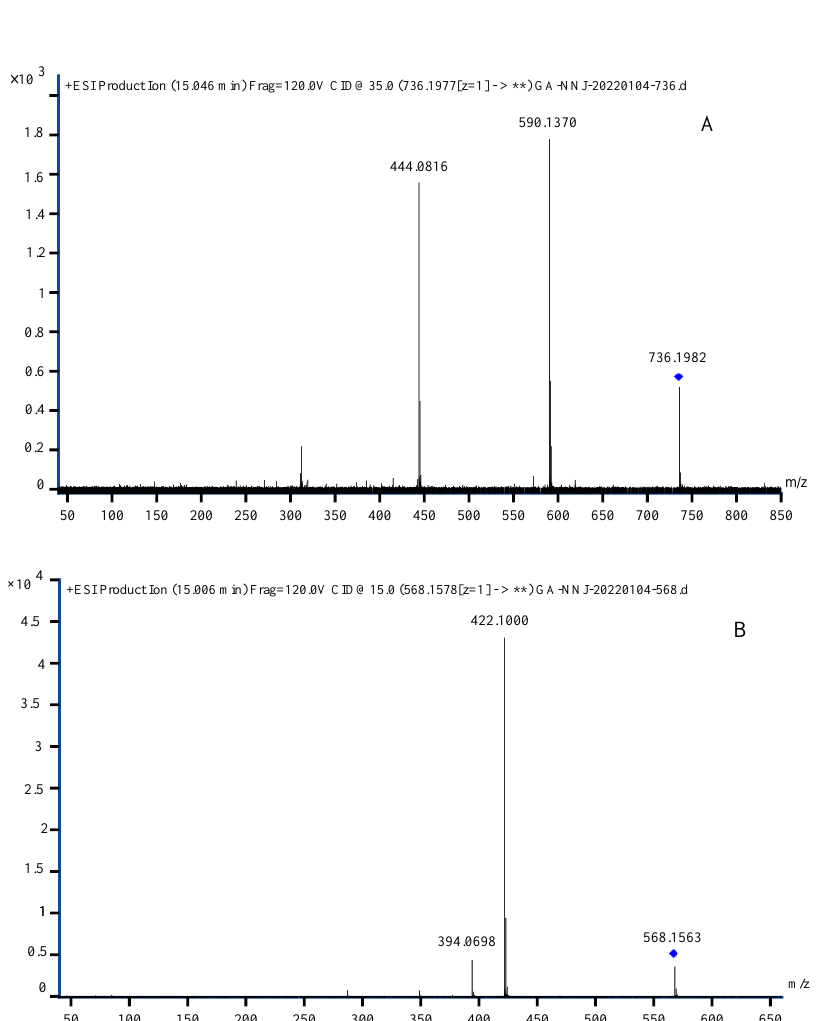
Figure 8. PIMS of m / z 736.1977 ( A ) and m / z 568.1578 ( B ) found in the extract of Arabidopsis thaliana (L.) exposed to Tabun. The blue sign was used to mark the precursor ion. Table 6. The deviations between calculated and observed m / z values of each fragment derived from compound 6.